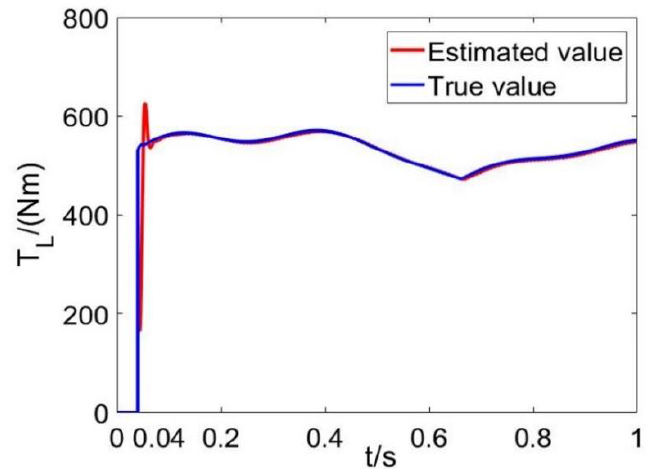
Figure 7. The estimated value of load torque.